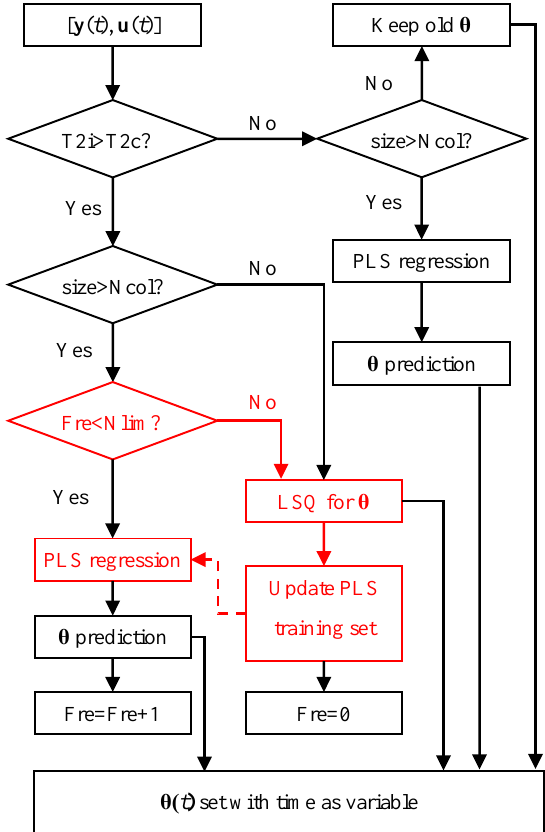
Figure 2. Correction framework of partial least squares (PLS) by least squares (LSQ).